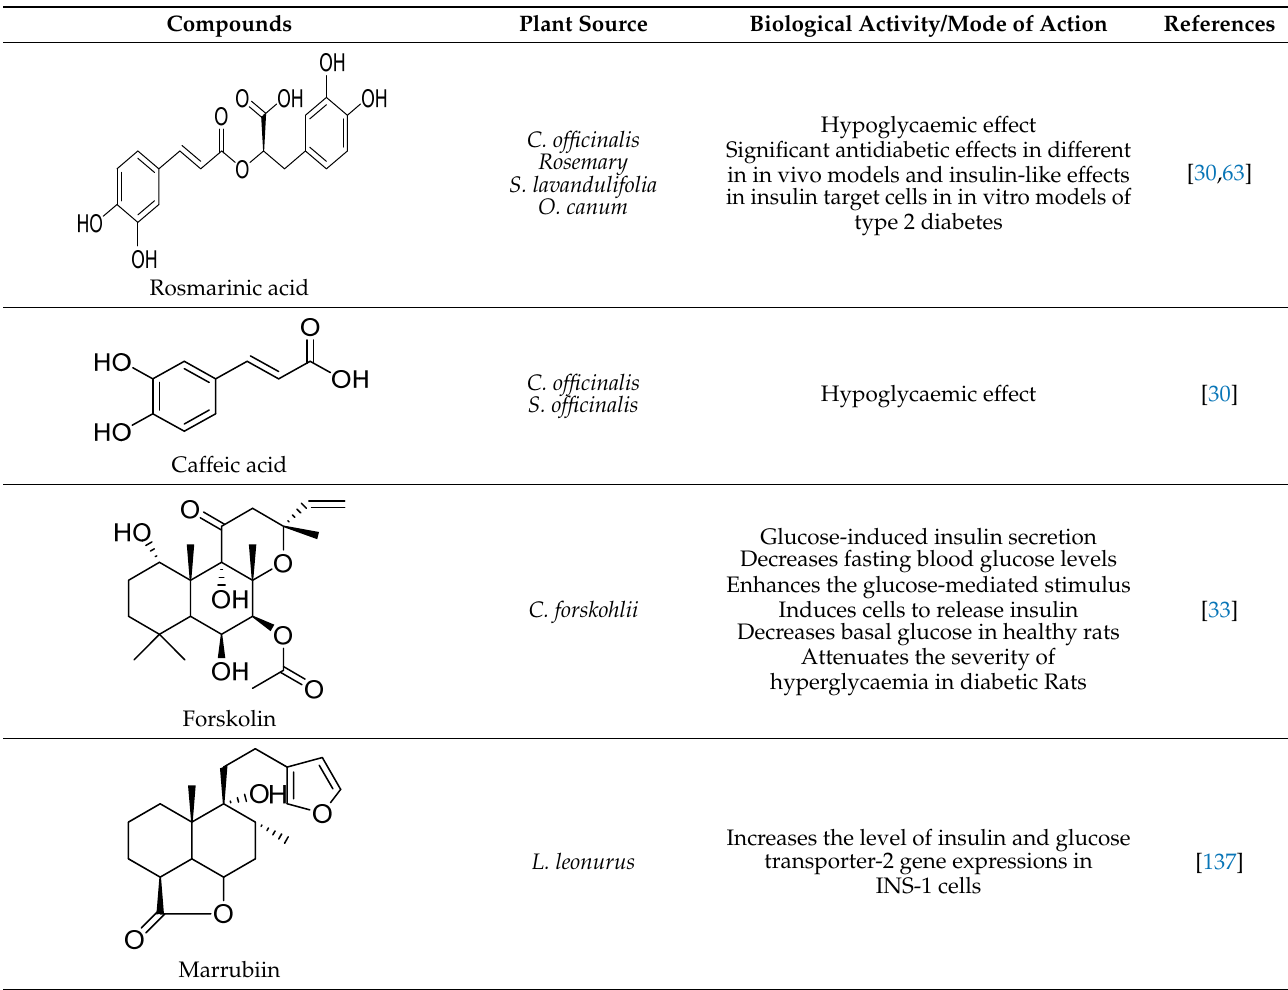
Table 2. Antidiabetic activity of different constituents of the Lamiaceae species.